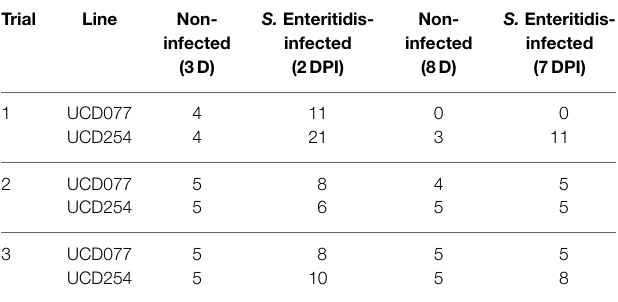
TABLE 1 | Summary of number of chickens used in each of the replicate trials for 16S rRNA gene sequencing analysis